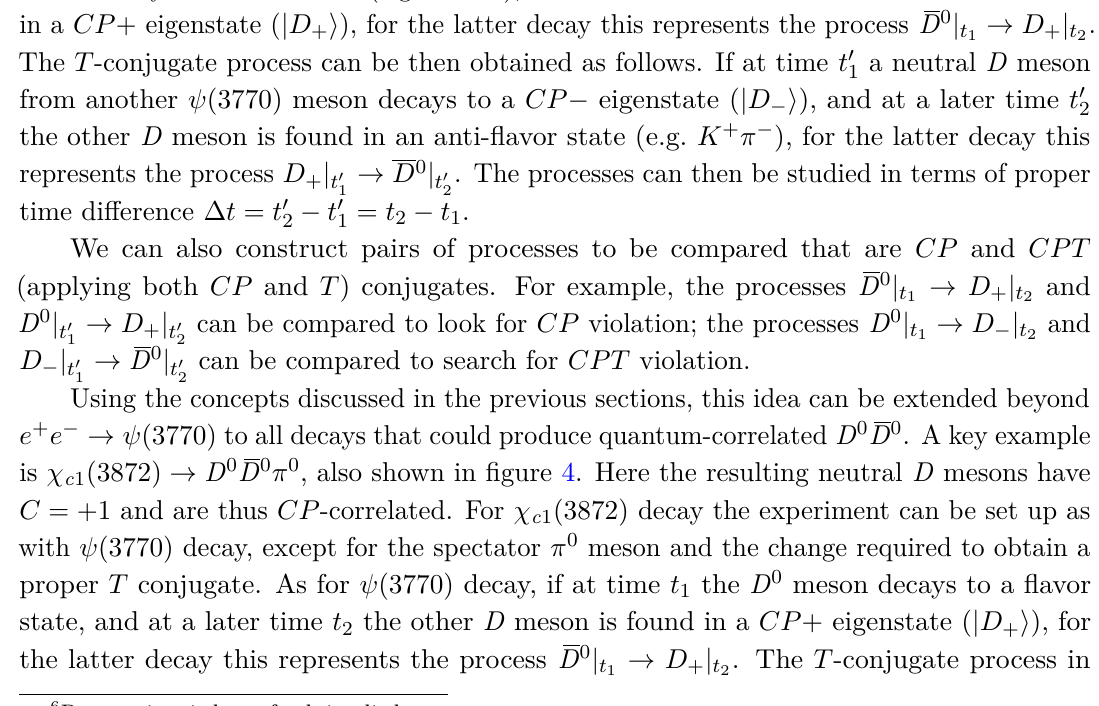
JHEP03(2023)038